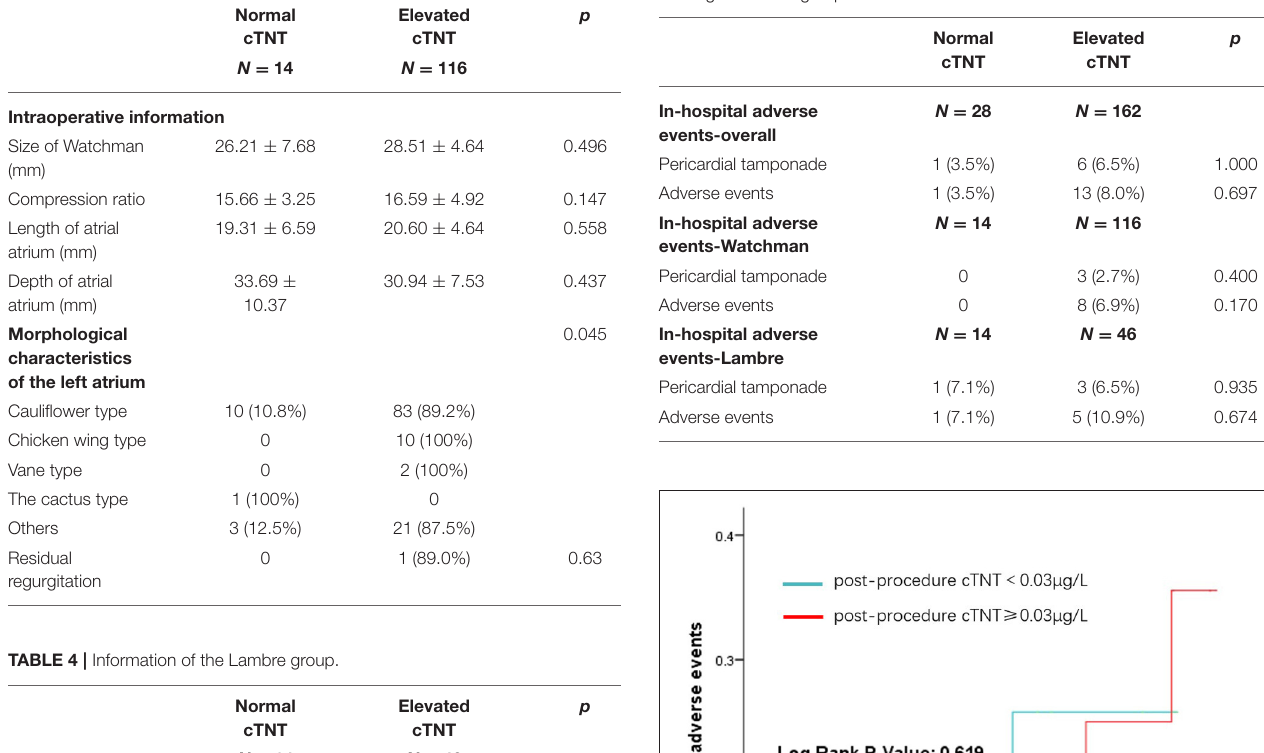
TABLE 5 | Periprocedural complications between the positive cTNT group and the negative cTNT group.